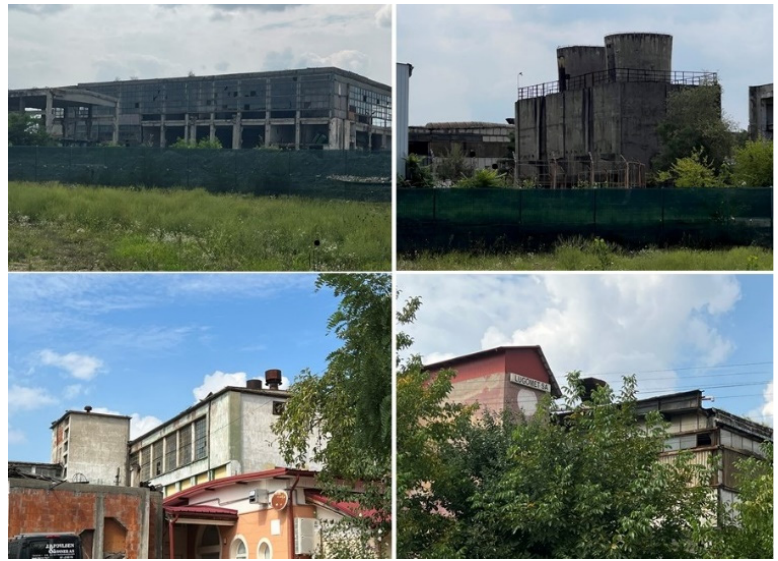
Figure 9 . Ruins of old local industries remaining in the northern industrial area (photos taken by author, July 2022).